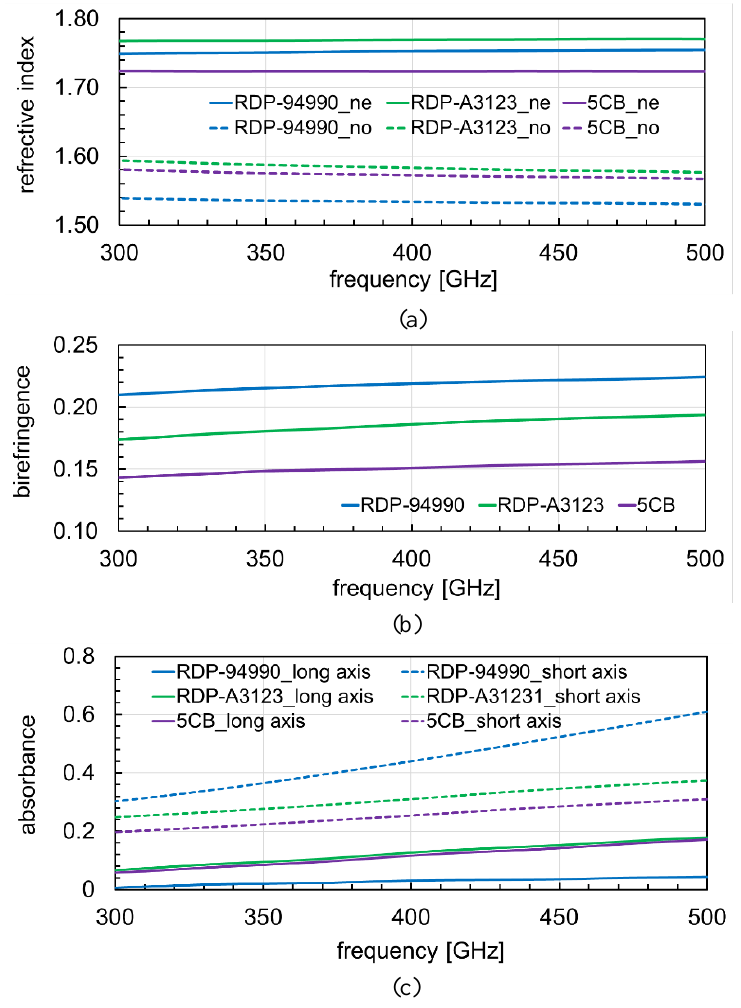
Figure 8. ( a ) refractive indexes, ( b ) birefringences, and ( c ) absorbances of 5CB, RDP-A3123, and RDP-94990 between 300 GHz and 500 GHz.